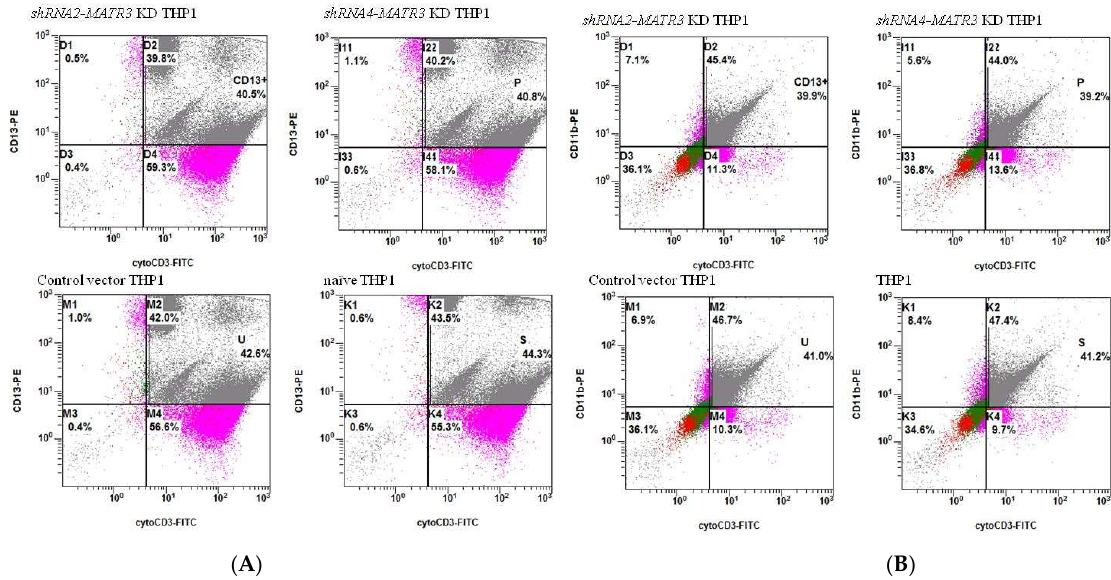
Figure 7. Jurkat E6 cells were treated at ( A ) 56 °C for 30 min to induce apoptosis ( B ) 37 °C for 30 min, and co-cultured with shRNA2-MATR3 KD THP1 cells, shRNA4-MATR3 KD THP1 cells, control vec- tor transfected THP1 cells, and naïve THP1